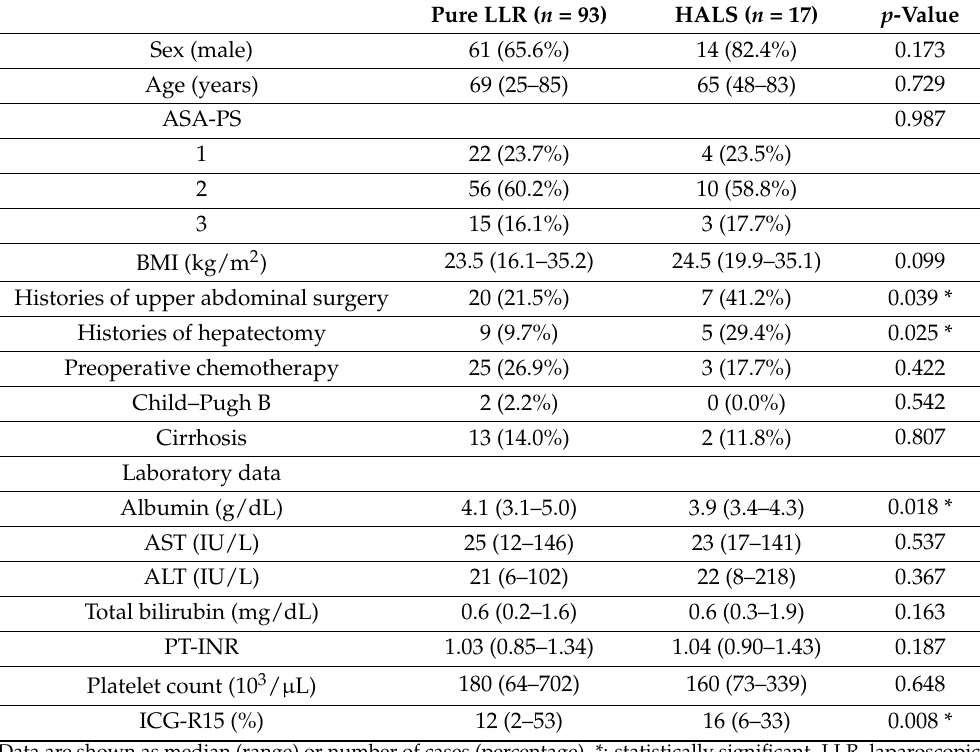
Table 5. Characteristics of patients that underwent pure laparoscopic and HALS PSH for lesions in PSS 7 and 8.